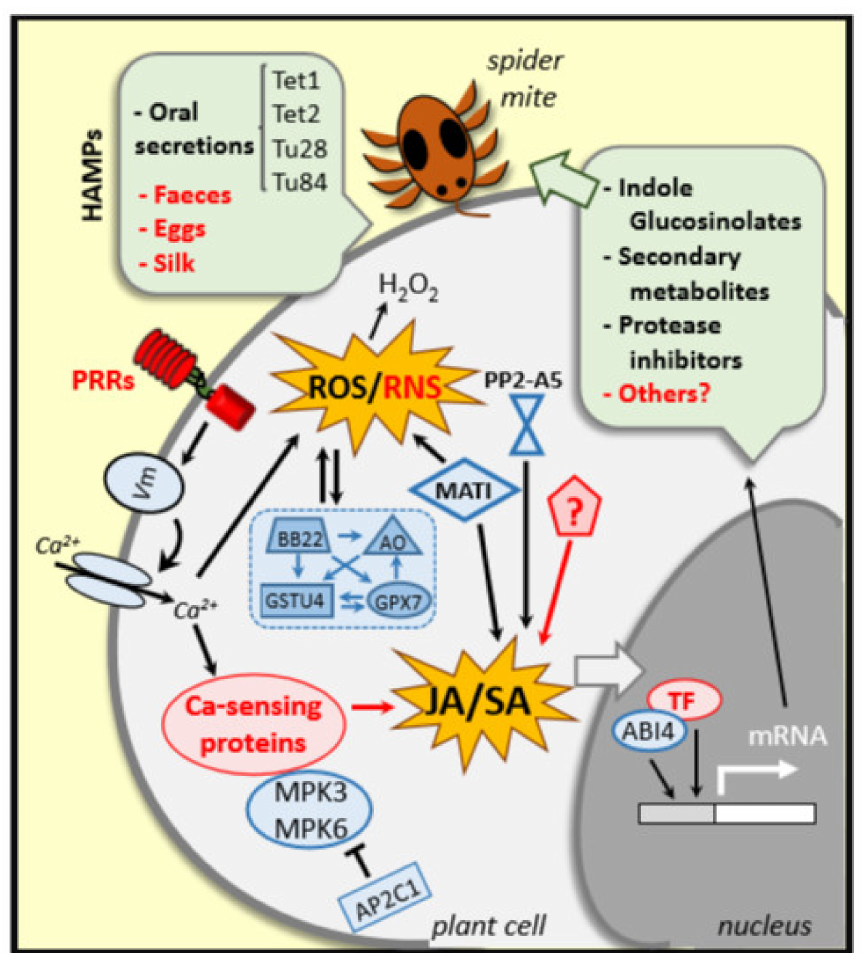
Figure 2. Plant event in responses to T. urticae infestation. Specific plant receptors (PRRs) recognize elicitors / e ff ectors (HAMPs) derived from either the plant or the spider mite that induce alterations in the membrane potential ( V m), cytosolic Ca 2 + influxes and ROS / RNS burst. Ca 2 + -sensing proteins, MPKs and phosphatases (APC21) participate in the defense transduction pathway. H 2 O 2 content is highly regulated by ROS-related enzymes (BB22, AO, GSTU and CPX7). Besides, genes such as MATI , PP2A5 and others still unknown participate in the tight regulation of the hormonal crosstalk, mainly in the Jasmonic Acid / Salicylic Acid balance. All together plus some transcription factors (ABI4 and other unknown TFs) regulate the induction of the synthesis of a battery of defense molecules. Unknown genes, molecules, pathways and responses are indicated in